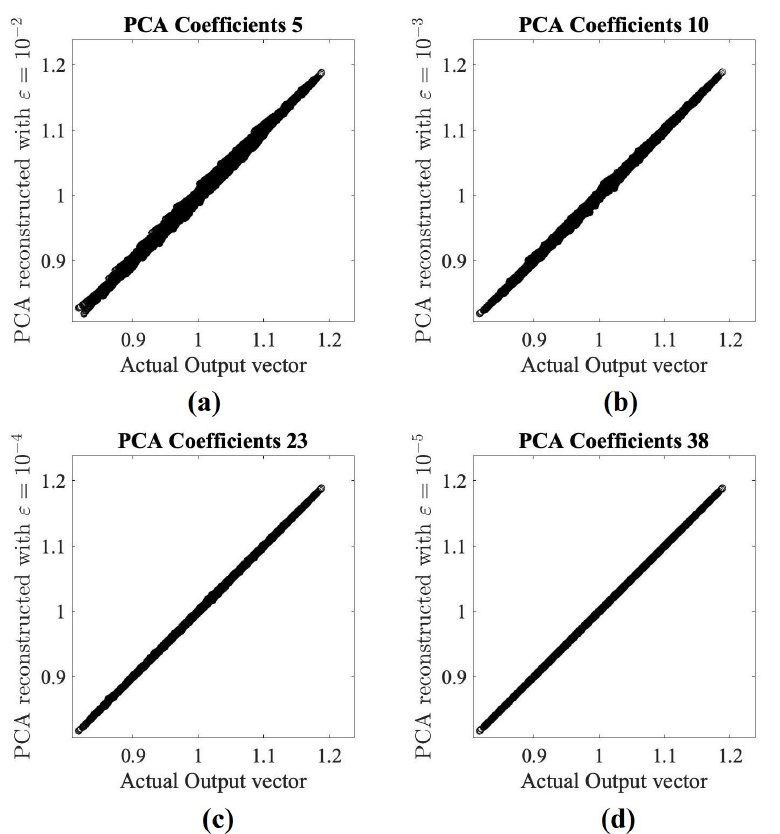
Figure 7. Scatter plots showing the actual training samples versus their reconstruction from PCA truncations with increasing number of components as shown in the plot